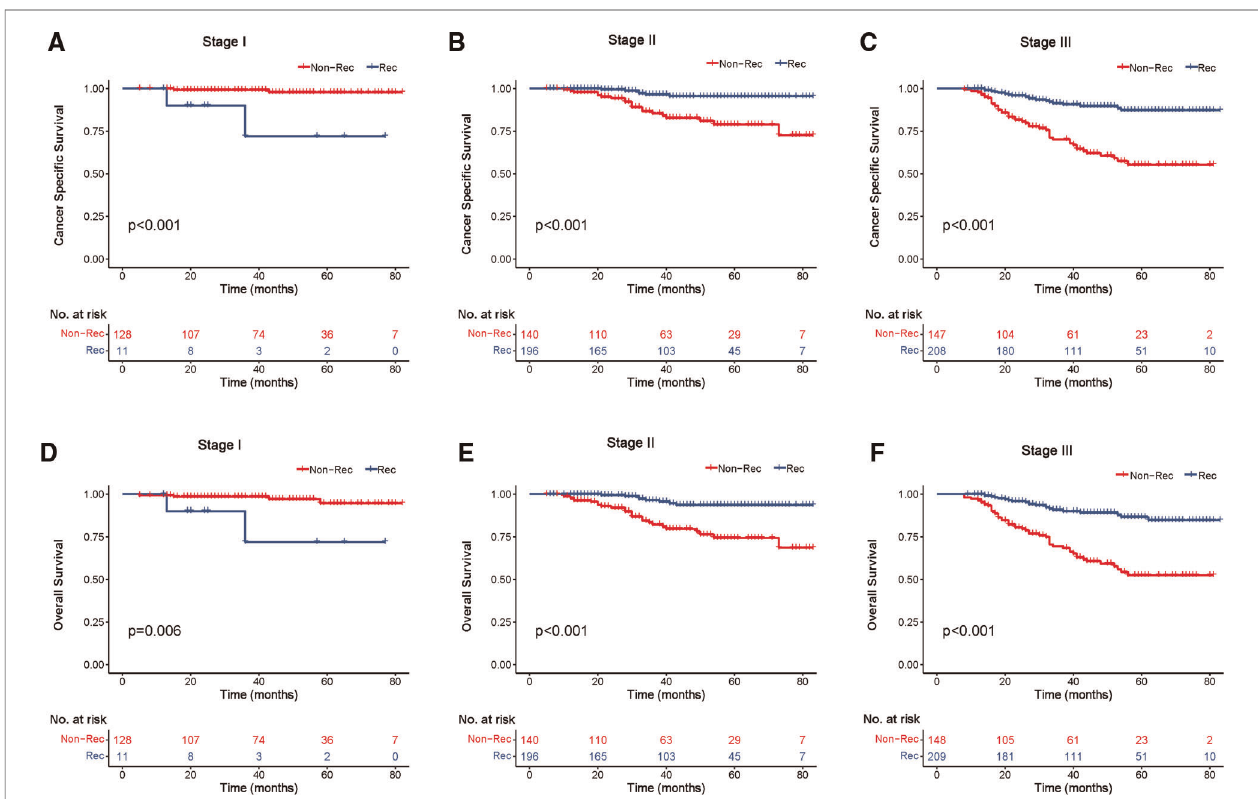
FIGURE 4 | Kaplan – Meier curves of breast cancer-speci fi c survival and overall survival in the reconstruction and non-reconstruction groups strati fi ed by different stages. Breast cancer-speci fi c survival ( A ) stage I, ( B ) stage II, and ( C ) stage III. Overall survival ( D ) stage I, ( E ) stage II, and ( F ) stage